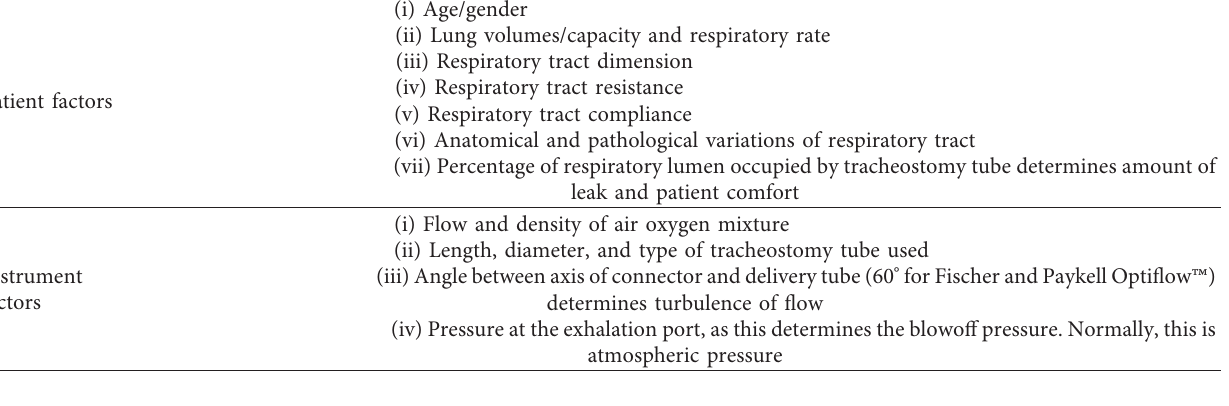
Table 2: Factors affecting PEEP in HFT.